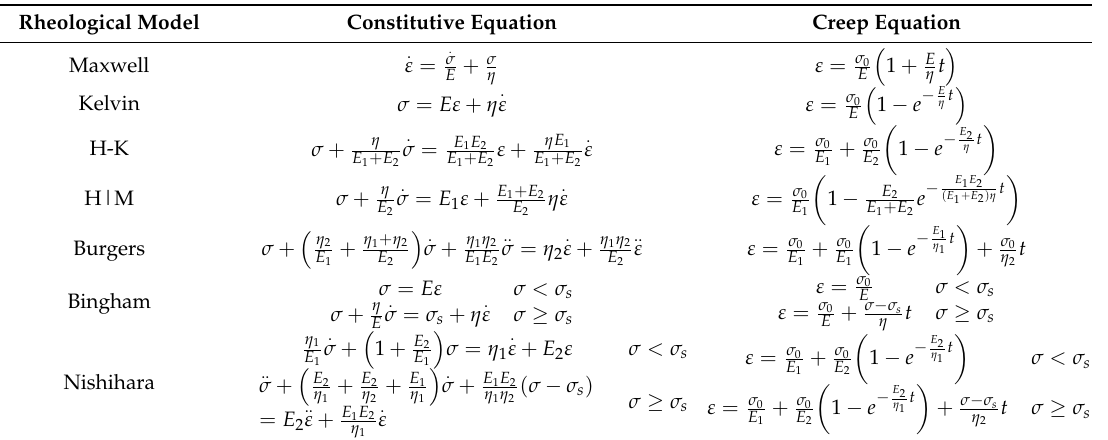
Table 1. Constitutive equations and creep equations for seven rheological models.